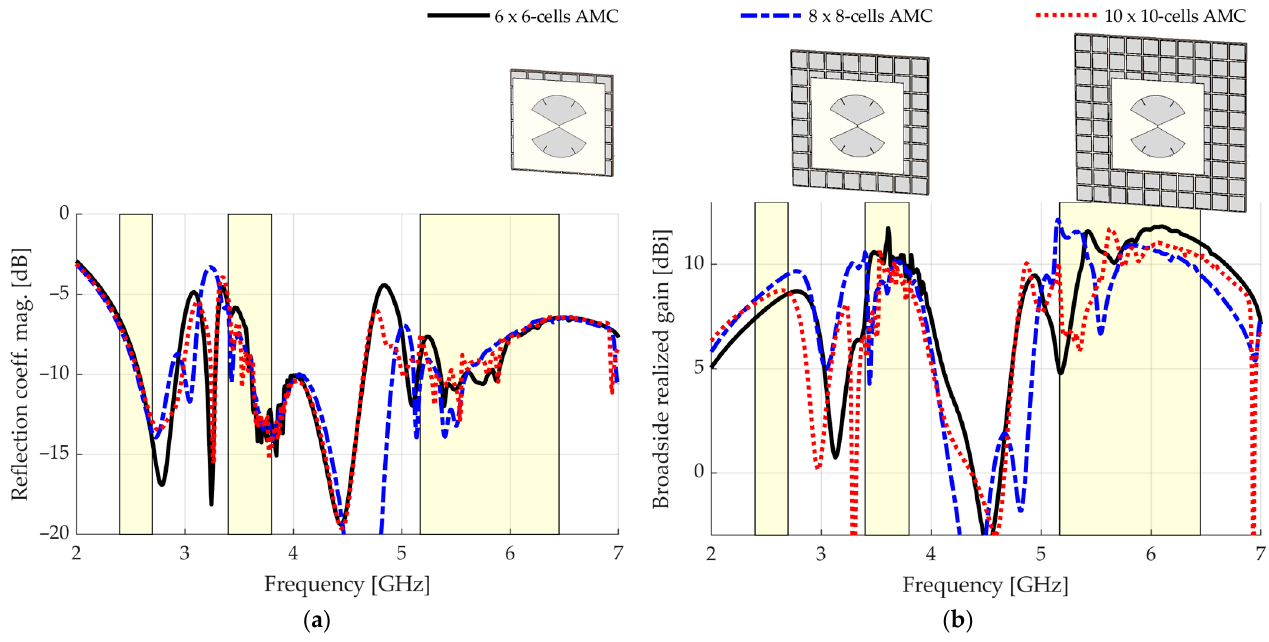
Figure 8. Simulated results when the number of cells varies: ( a ) reflection coefficient magnitude; ( b ) broadside realized gain.